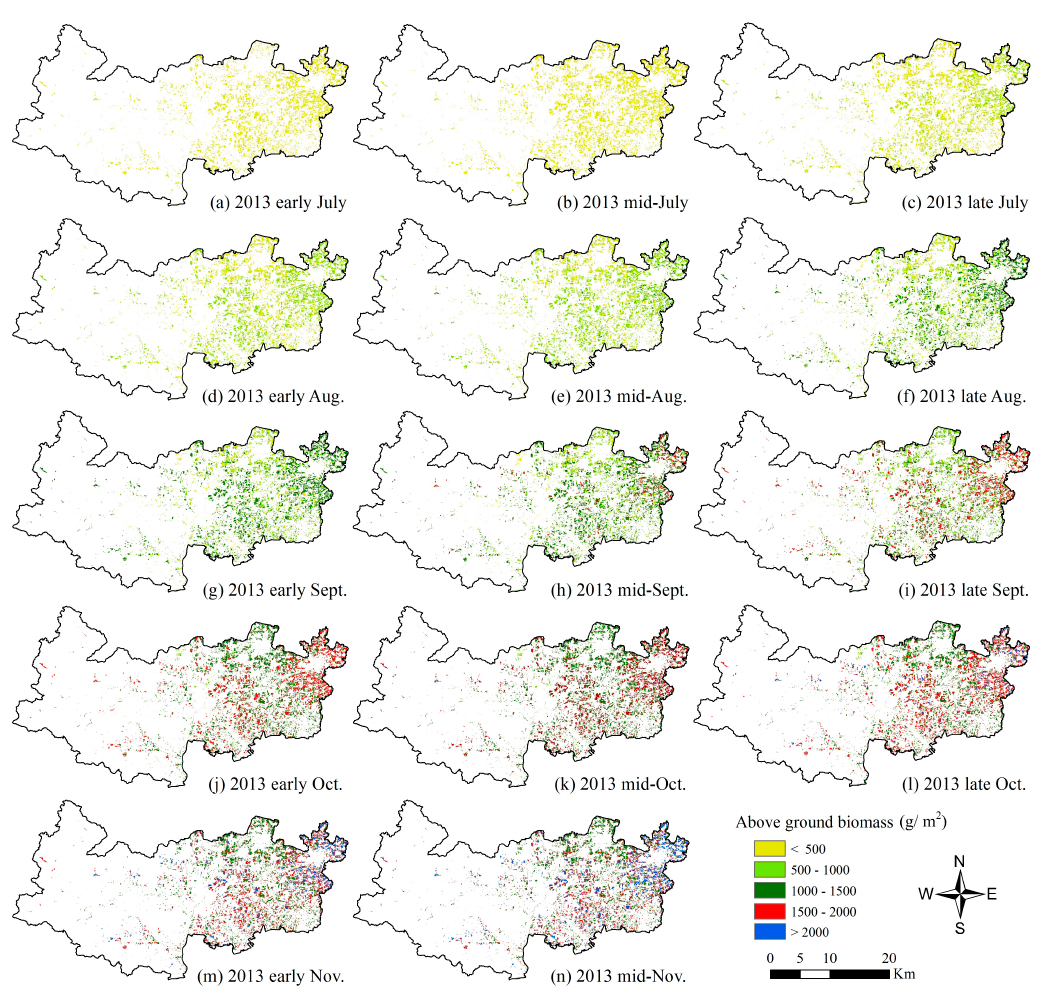
Figure 10. Dry aboveground biomass dynamic mapping of single-cropped rice in Deqing County in 2013.